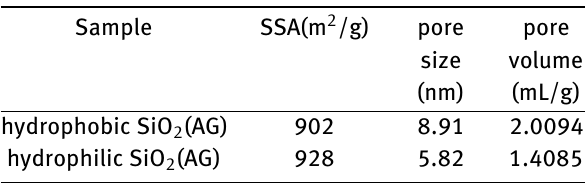
pore size volume (nm) (mL/g)